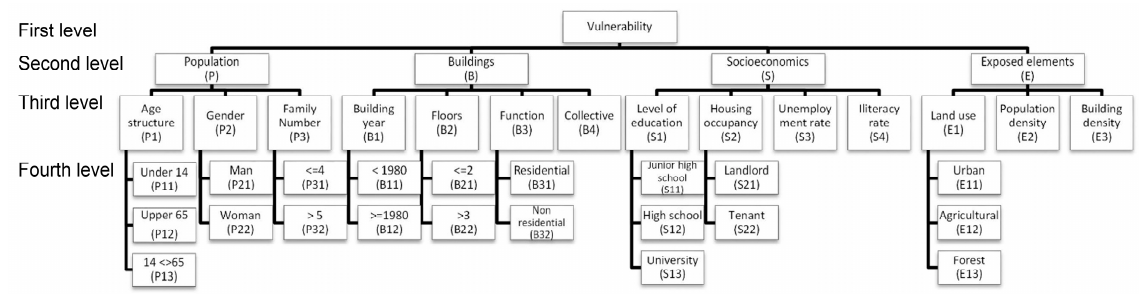
Figure 3. The hierarchical structure of the fl ood vulnerability criteria used in